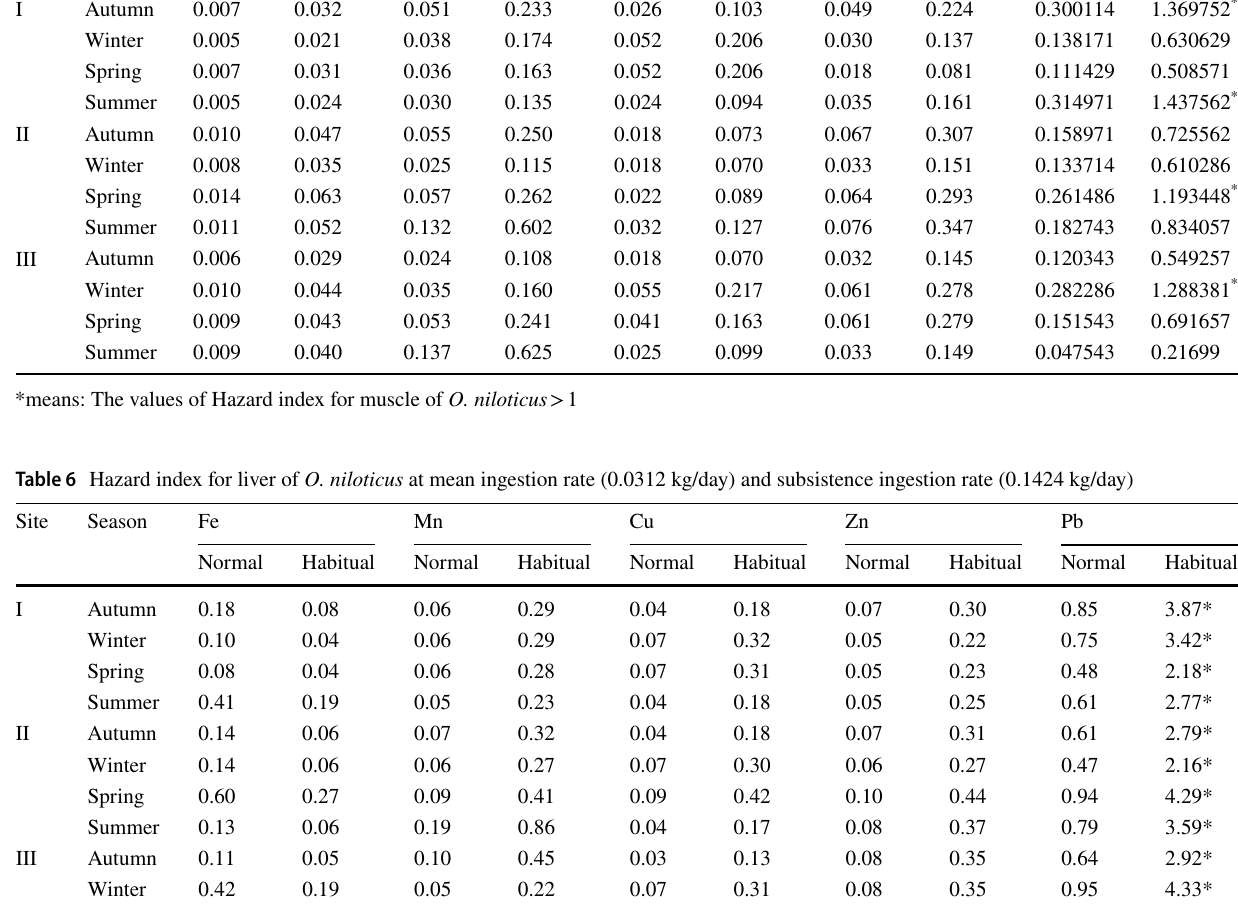
*means: The values of Hazard index for liver of O. niloticus